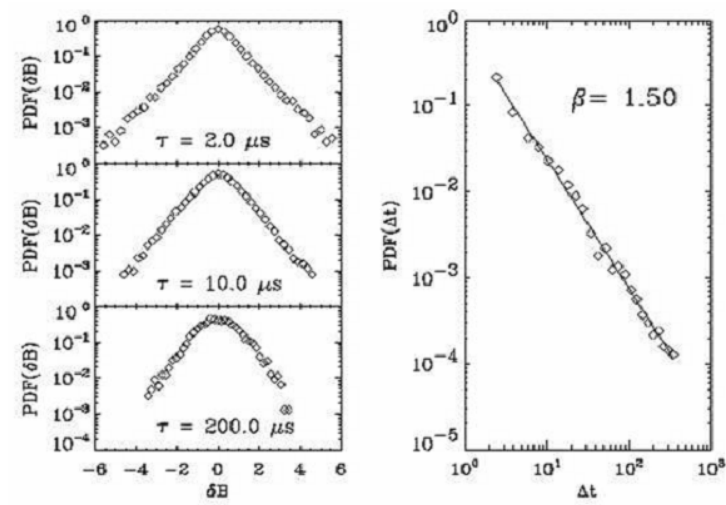
Figure 84: Left panel: normalized PDFs of the radial magnetic field collected in RFX magnetic turbulence (Carbone et al. , 2000). Right panel: distribution function of waiting times Δ 𝑡 between structures at the smallest scale. The parameter 𝛽 is the scaling exponent of the scaling relation PDF(Δ 𝑡 ) ∼ Δ 𝑡 − 𝛽 for the distribution function of waiting